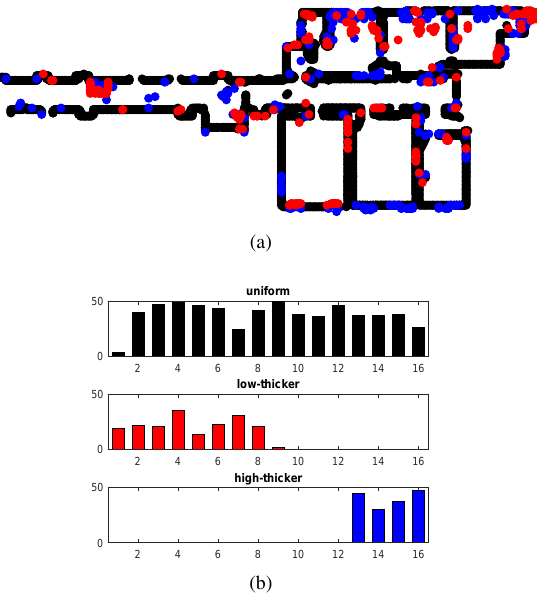
Figure 2. Classification of the wall samples (a) into U/L/H with examples of histograms (b).